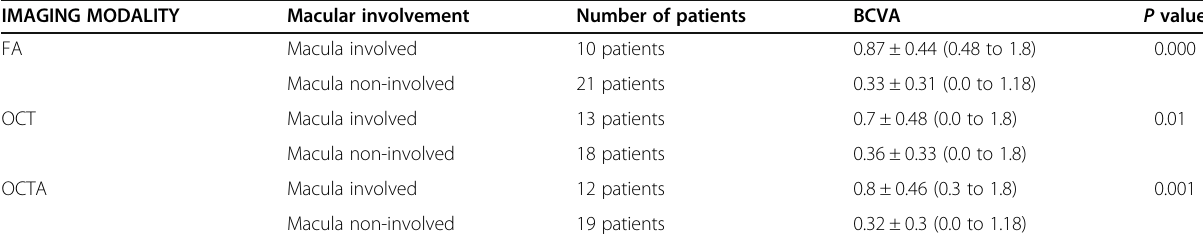
Table 4 Comparison of mean BCVA among patients with or without macular involvement on FA, OCT and OCTA IMAGING